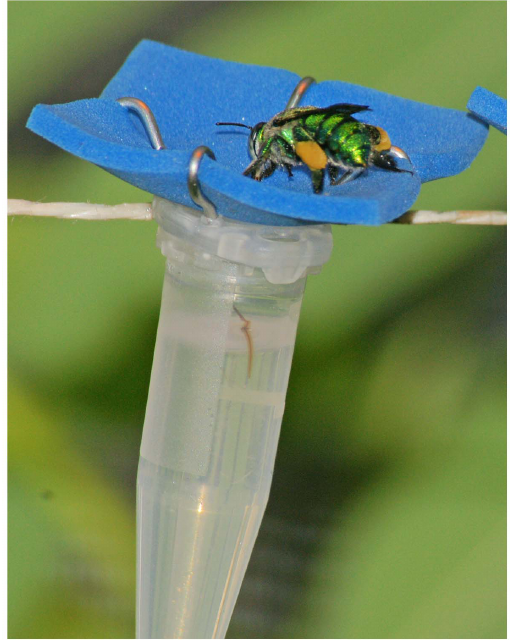
Figure 1. Artificial flowers. Female Euglossa viridissima drinking from an artificial flower (constructed from a 1.5 ml Eppendorf tube and foam rubber) containing sugar-water solution. The tip of the glossa can be seen just above the 1 ml mark of the Eppendorf